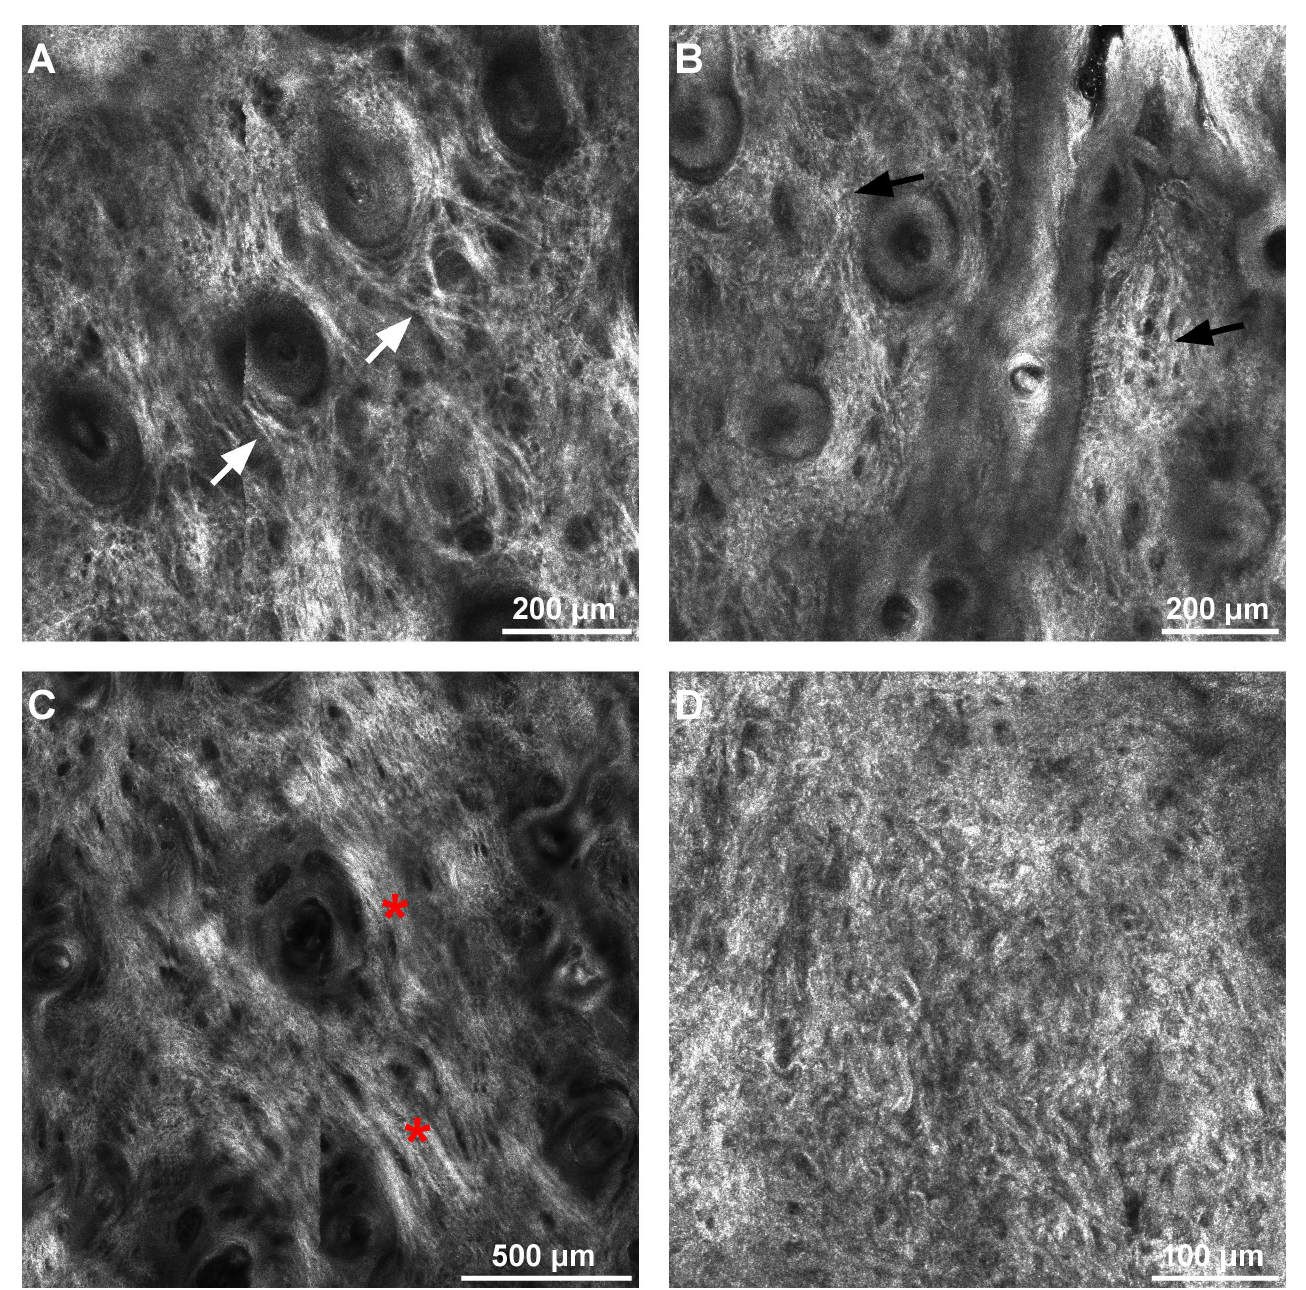
Table 4, thin collagen fibers arranged in a reticular pattern characterized young subjects (age groups I and II) and progressively decreased in favor of coarse and huddled collagen in the remaining age groups. Huddled collagen, observable in a few cases up to group III, was notably present in groups IV and V. Curled fibers were exceedingly present in age group V, although detectable in a few instances in age groups III and IV. Figures 7 and 8 show confocal microscopy images of the dermal score, which include various collagen fiber types and longitudinal vessels.